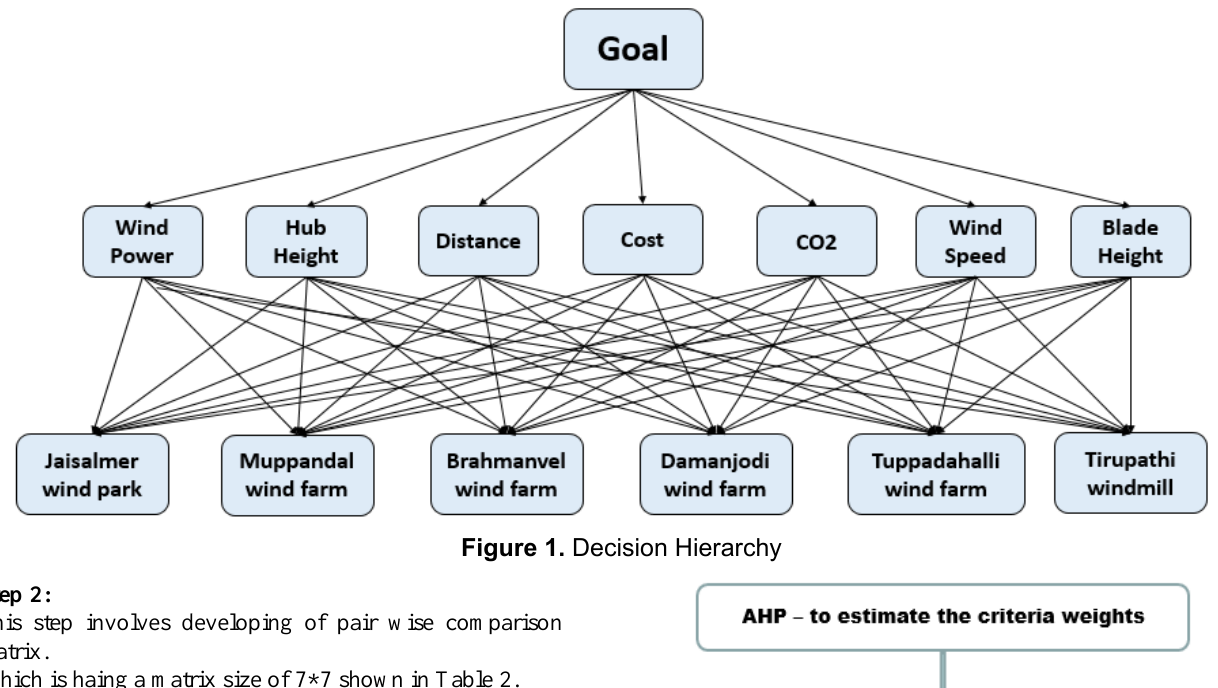
Figure 1. Decision Hierarchy